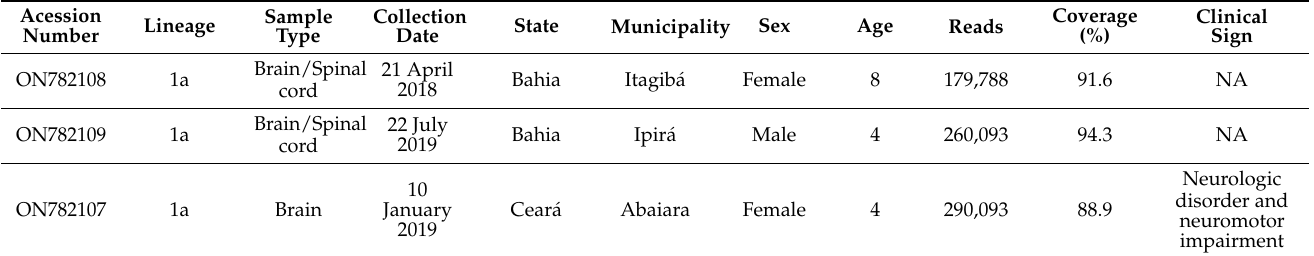
Table 1. Epidemiological information and sequencing statistics of the three sequenced samples of WNV sampled in the Brazilian states of Bahia and Cear á